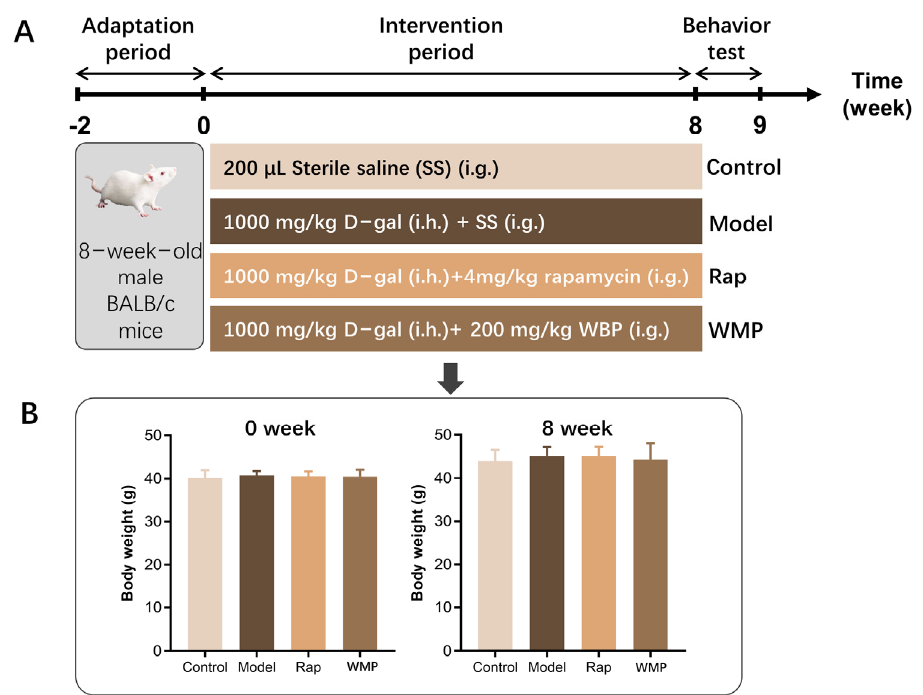
Figure 1. The design scheme of the animal experiment ( A ) and the effects of WMP on body weights of D-gal-induced aging mice ( B ). i.g. intragastric; i.h., hypodermic injection. of D-gal-induced aging mice ( B ).i.g. intragastric; i.h., hypodermic injection.